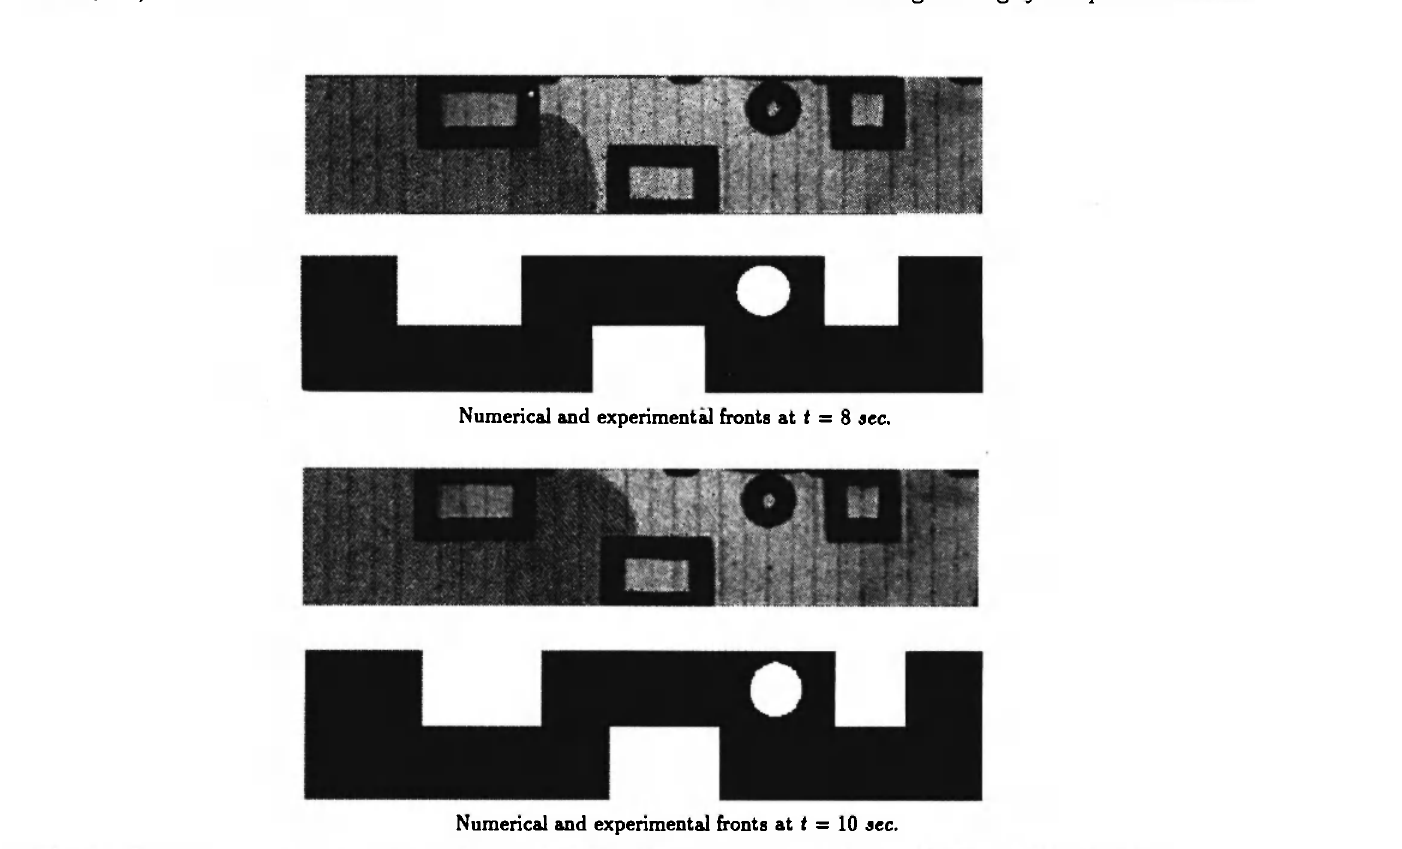
Fig. 4: Comparison of experimental and numerical flow fronts across obstacles: beginning of injection (times 8 and 10 sec).